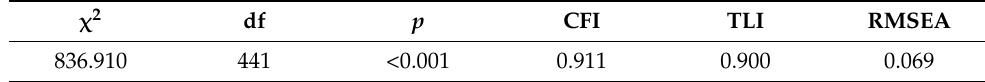
Table 7. Structural equation model’s fit analysis results.